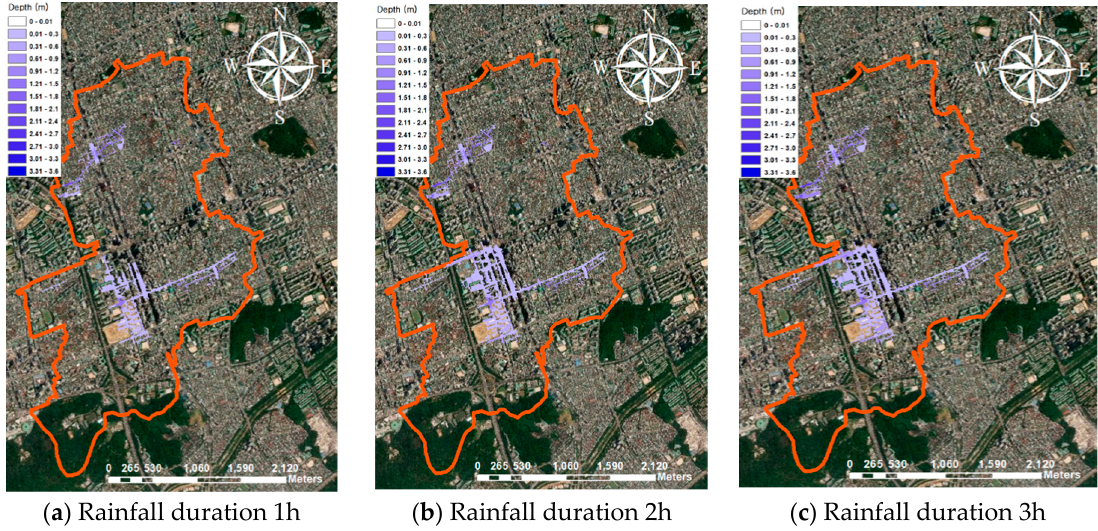
Figure 11. Inundation map simulated with two-dimensional flood analysis. ( a ) Rainfall duration 1h;